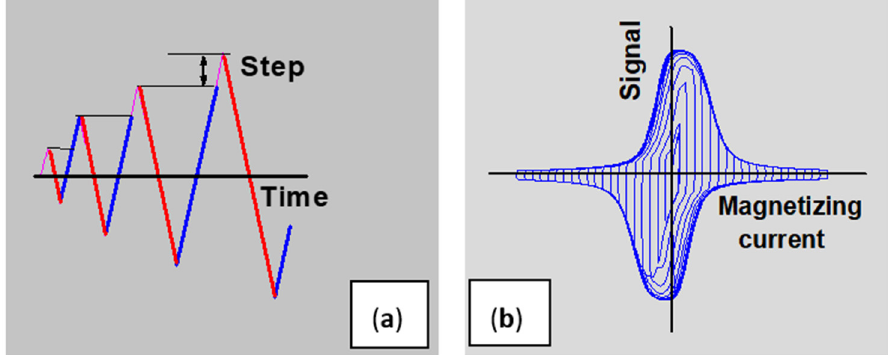
Figure 3. Time variation of magnetizing current ( a ) and the detected permeability loops ( b ).